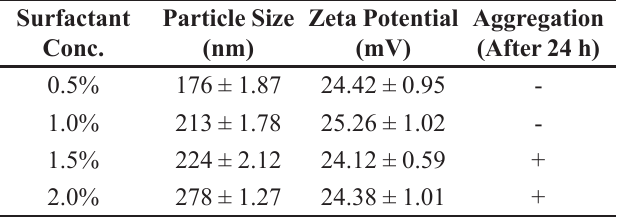
TABLE IV - Optimization of Surfactant